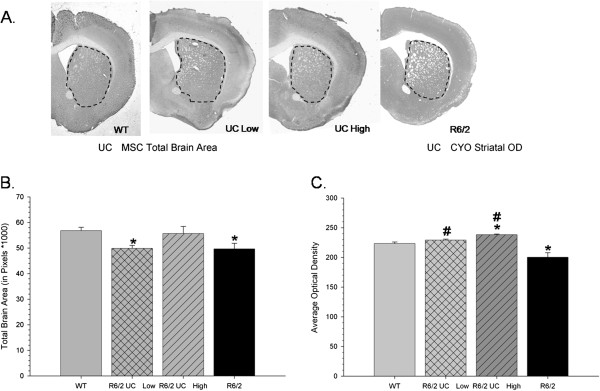
Measures of brain area and evidence of integrity of the metabolic tissue in the striata of mice receiving umbilical cord mesenchymal stem cell transplantations. Gross morphology of the brain near the area of transplantation can be visualized with cytochrome oxidase labeling (A). Untreated R6/2 mice and mice that received transplantation of low-passaged UCMSCs had a significant decrease in total brain area when compared to WT mice (B). Optical densitometric measures of cytochrome oxidase in the striata (outlined in dashed line) revealed significantly less metabolic activity of striatal tissue in untreated R6/2 mice, when compared to WT mice at the time of necropsy (C). R6/2 mice that received transplantation of low- or high-passaged UC MSCs had significantly higher levels of metabolic activity in striatal tissue than did untreated R6/2 mice. (Note: *significant from WT; #significant from R6/2). Line graph represents mean value; error bars represent SEM. SEM, standard error of the mean; UCMSCs, umbilical cord mesenchymal stem cells; WT, wild type.